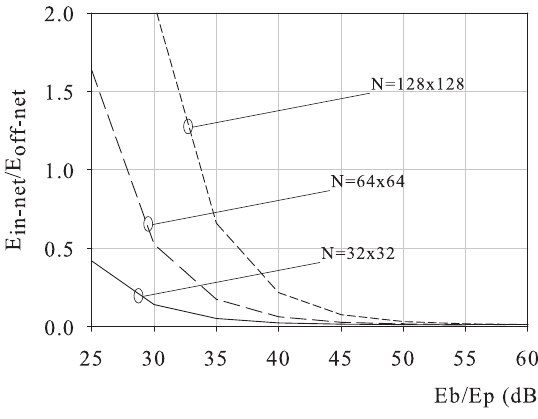
Figure 2. E in-net / E off-net versus E b / E p , L = 8, ρ CS = 0.2, ρ enc =